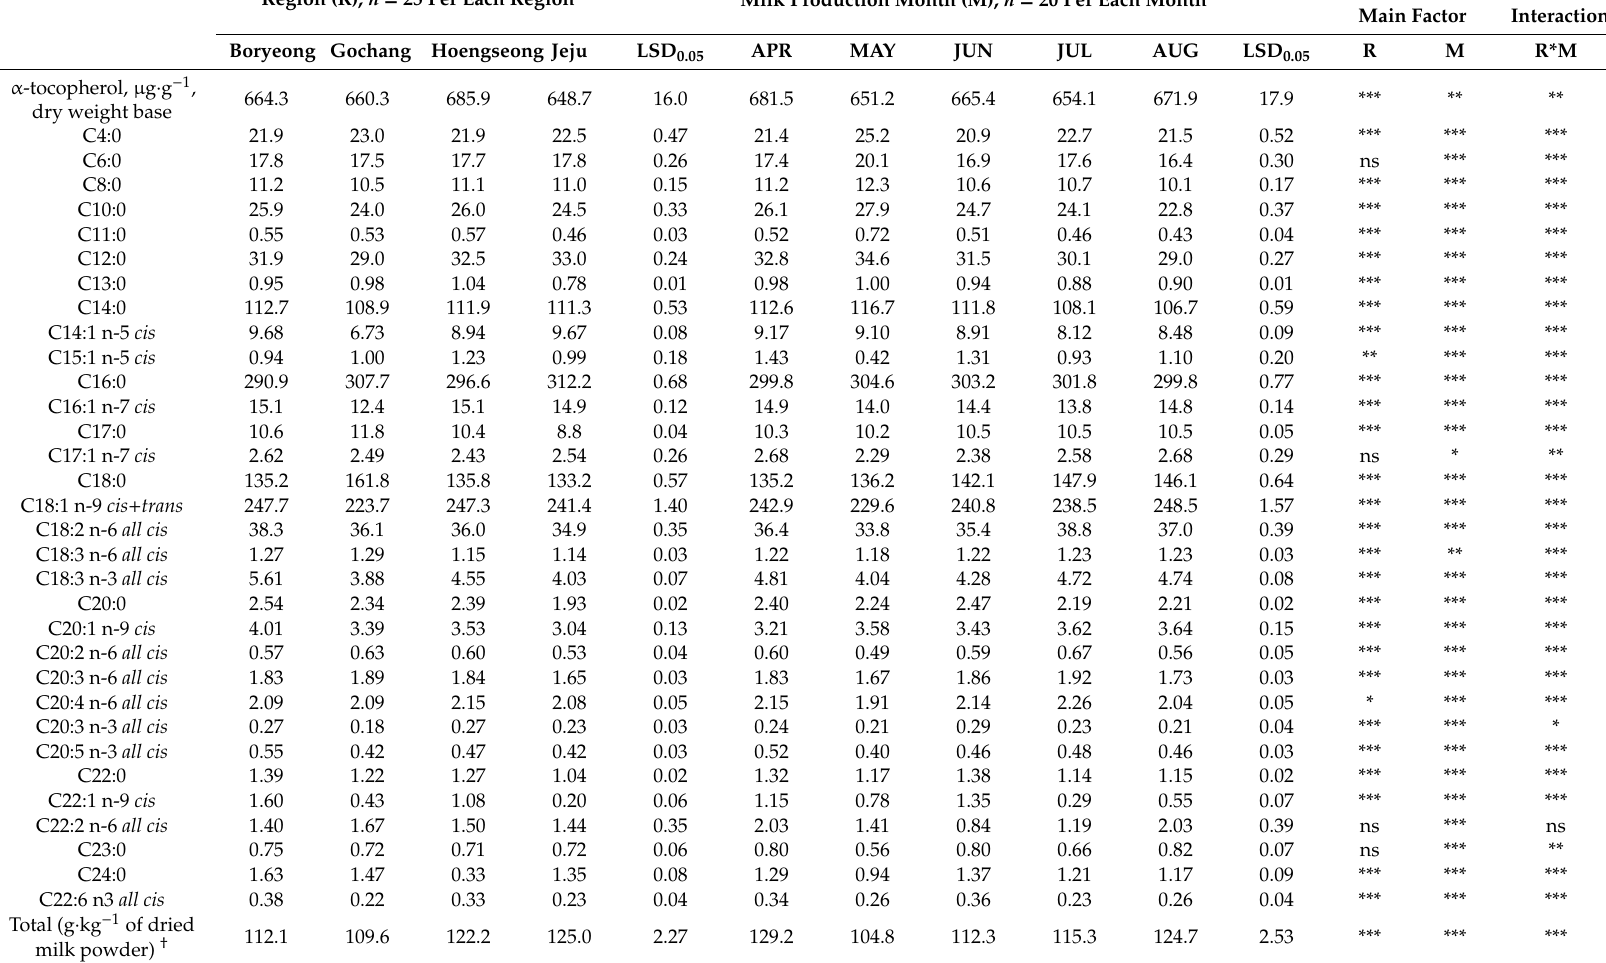
Table 2. Means of regional and monthly di ff erence of α -tocopherol ( α -TOC, µ g · g − 1 , dry weight base) and fatty acid content (FA, g · kg − 1 of total fatty acids) in organic milk